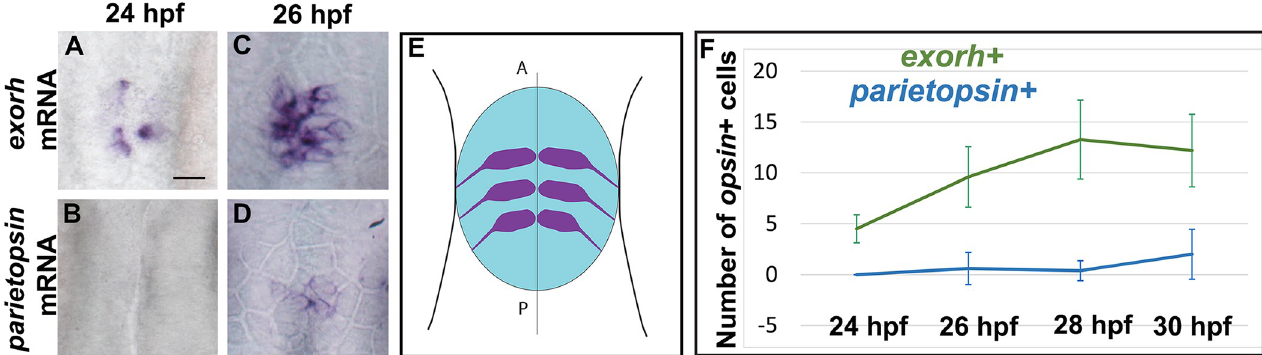
Fig 2. Expression of exorh and parietopsin follows a temporal sequence. (A-D) In situ hybridization for exorh or parietopsin at 24 and 26 hpf. At 26 hpf, only 2 out of 10 embryos showed parietopsin + cells; in these embryos, parietopsin expression is restricted to the center of the pineal territory. (E) Schematic representation showing the pineal territory in blue and nascent neurons in purple, indicating the orientation of the images in (A-D); dorsal view with the anterior to the top. (F) Counts of exorh + and parietopsin + cells in embryos of various stages, which are indicated on the x-axis. Error bars represent SD. Number of embryos analyzed are n = 6, 5, 11, and 5 for exorh + cells at 24, 26, 28, and 30 hpf, respectively, and n = 10, 10, 21, and 5 for parietopsin + cells at the same stages. Scale bar represents 15 μ m. Underlying data can be found in S1 Data. exorh , exorhodopsin ; hpf, hours post